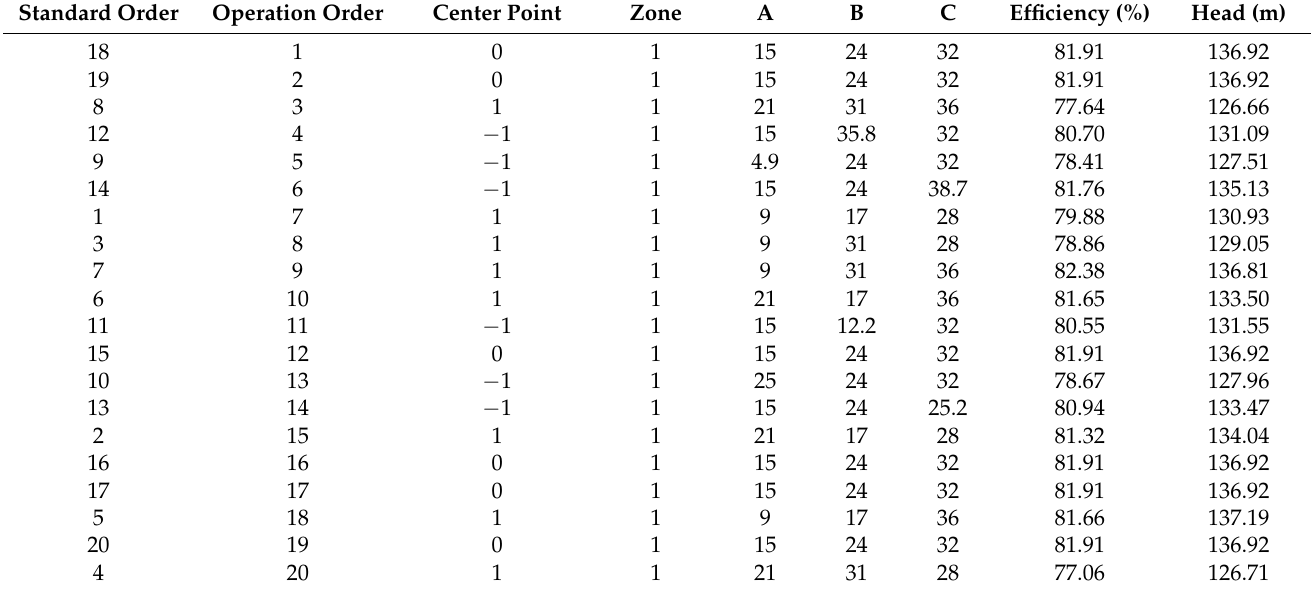
Table 8. Design plan and calculation results of the surface response experimental method.